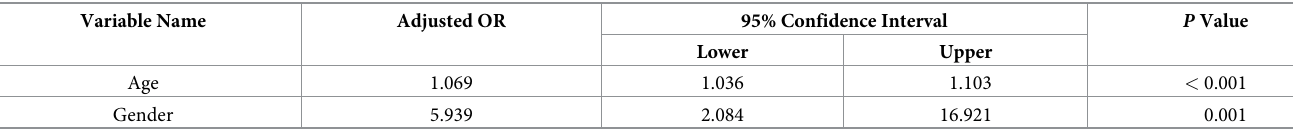
Table 2. Binary logistic regression for demographic characteristics and mortality rate.